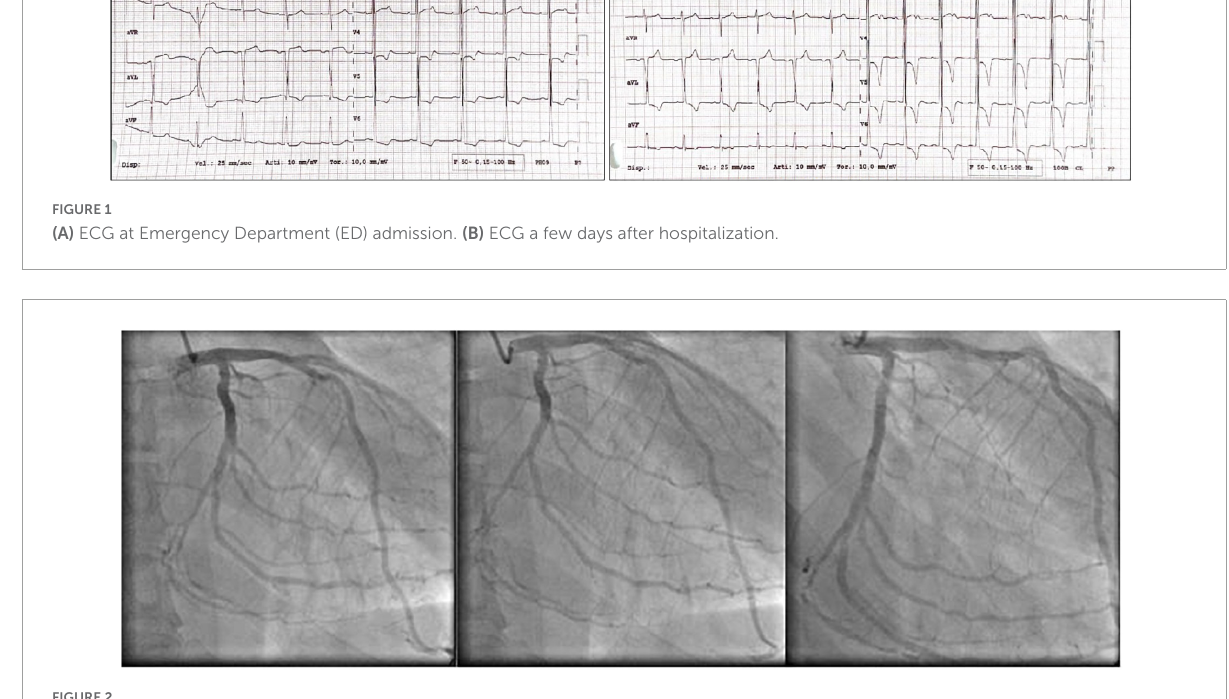
disease (because of the suspicion of infiltrative hypertrophic